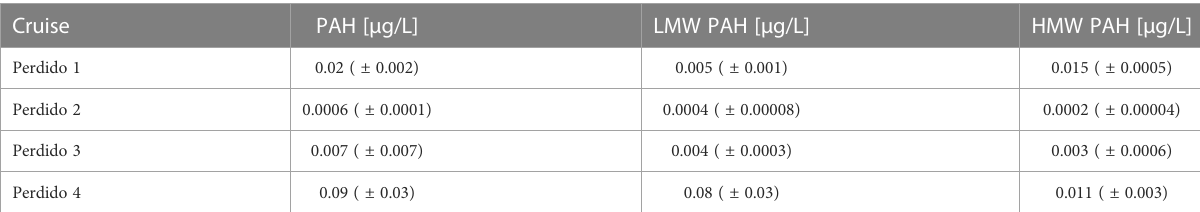
TABLE 2 Mean total PAH, low molecular weight (LMW), and high molecular weight (HMW) PAH concentrations (in µg/L) ( ± standard error of the mean) of each cruise. Cruise PAH [µg/L] LMW PAH [µg/L] HMW PAH [µg/L] Perdido 1